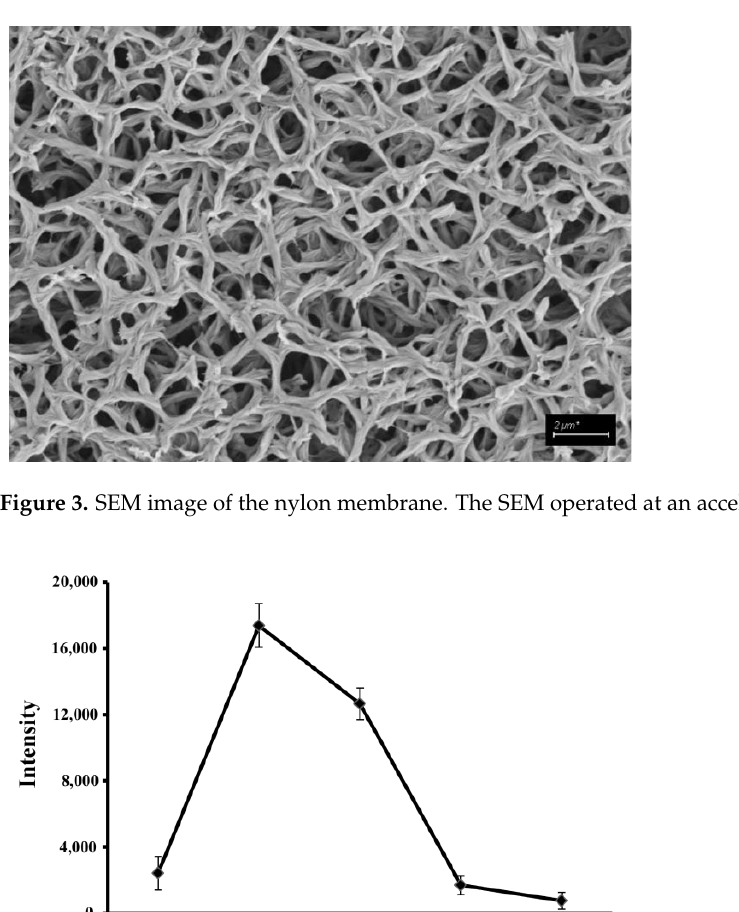
concentration, 5.0 μM. The mass spectrum was obtained by averaging 200 mass spectra using laser energy that slightly exceeded the threshold.